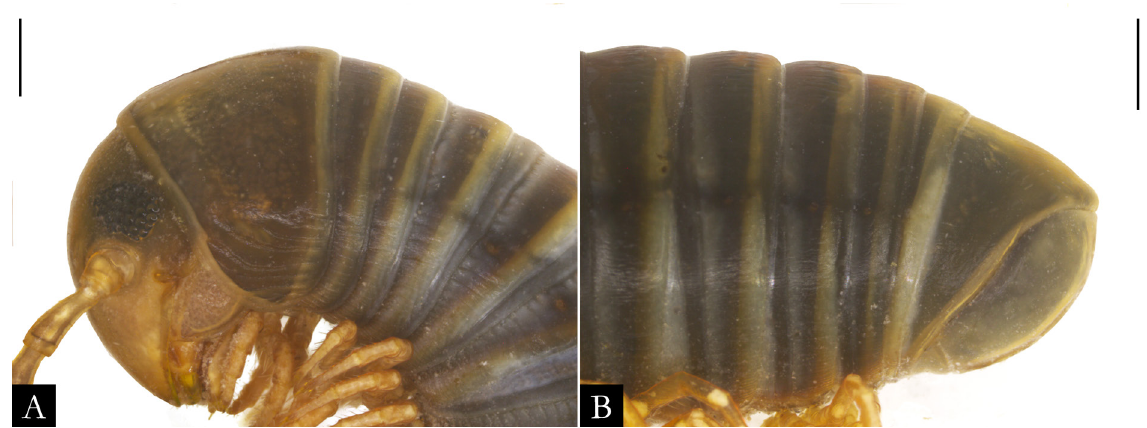
Fig. 93. Pseudonannolene mesai Fontanetti, 2000, ♀ (IBSP 2041), in lateral view. A . Anterior region. B . Posterior region. Scale bars = 1